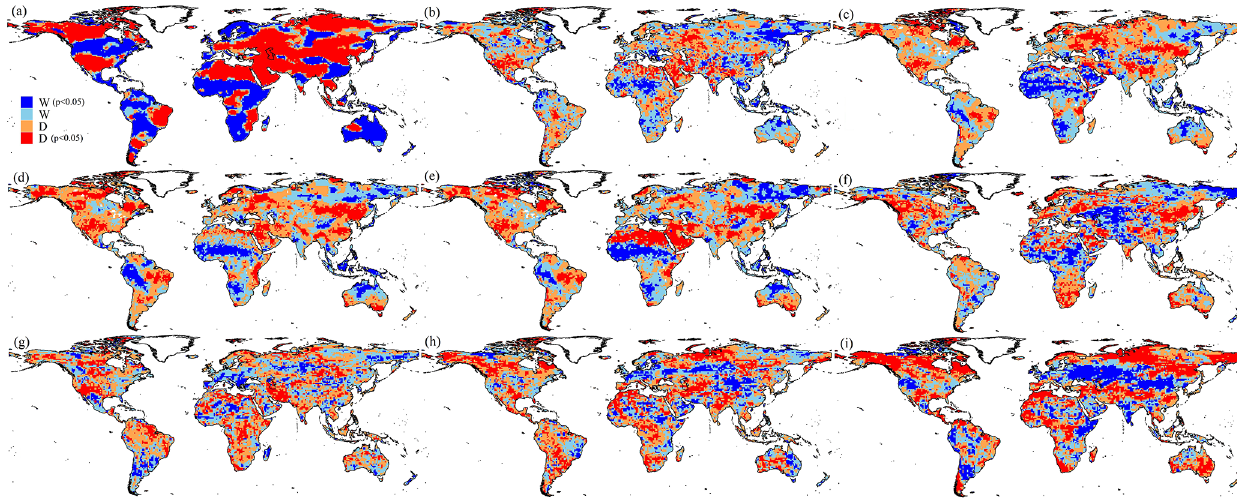
Figure 1. Global distribution of the classification in long-term trends in TWS-DSI during (a–f) the historical (1985–2014) and future (2071– 2100) periods under (g) SSP126, (h) SSP245, and (i) SSP585 scenarios. Note that the historical results are based on the (a) GRACE recon- struction, (b) WGHM, (c) VIC, (d) CLSM, (e) Noah, and (f) ensemble mean of eight GCMs, respectively. The future results are based on the ensemble of eight GCMs. “D” and “W” indicate regions with drying and wetting trends, respectively.